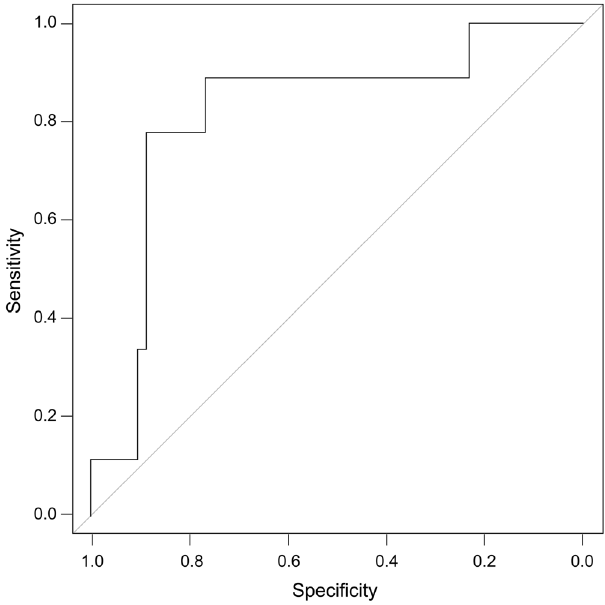
Figure 3. Receiver operating characteristic curve analysis of C-reactive protein level on postoperative day